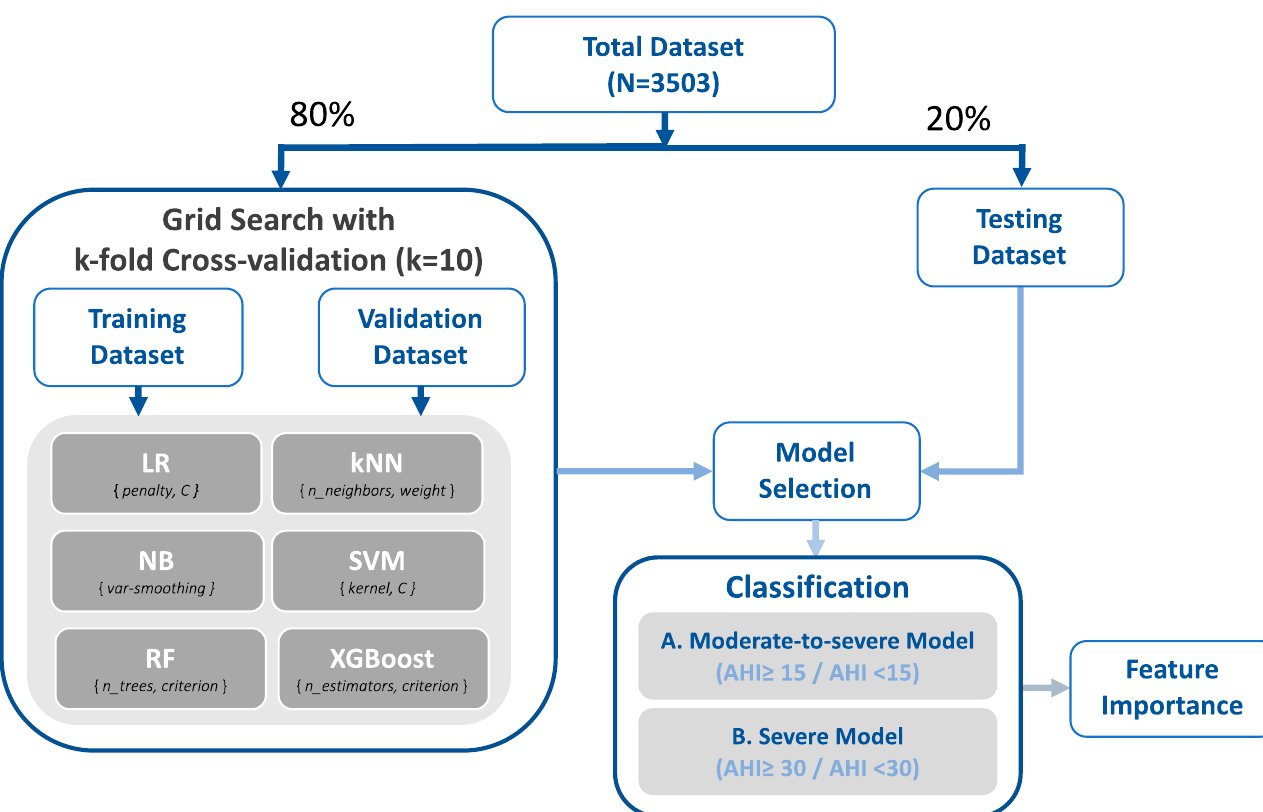
Figure 1. Training process with grid search cross-validation. Various machine learning models were trained using grid search cross-validation (k-fold: 10). The model demonstrating the highest accuracy in the validation stage was employed to predict the testing data, and the feature importance was investigated. Abbreviations: LR, logistic regression; C, regularization values; kNN, k-nearest neighbor; NB, naïve Bayes; var_smoothing, portion of the largest variance of all features; SVM, support vector machine; RF, random forest; n_trees, number of classifications and regression trees; XGBoost, extreme gradient boosting; n_estimators, number of gradient boosted trees; AHI, apnea– hypopnea index.